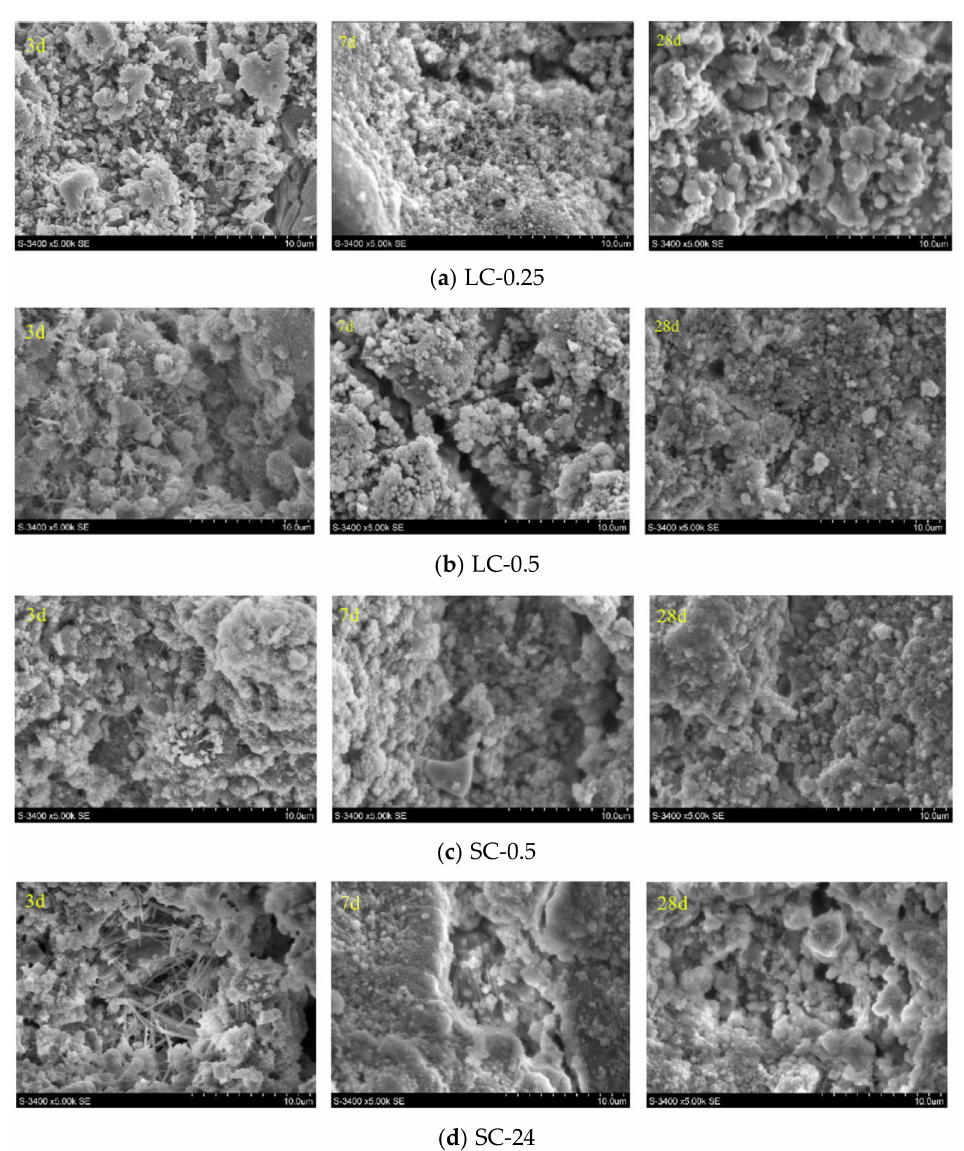
Figure 15. The SEM images of ITZ between the LWA and matrix: ( a ) Lytag LWA pre-wet for 0.25 h; ( b ) Lytag LWA pre-wet for 0.5 h; ( c ) Shale LWA pre-wet for 0.5 h; ( d ) Shale LWA pre-wet for 24 h [118], with copyright permission from